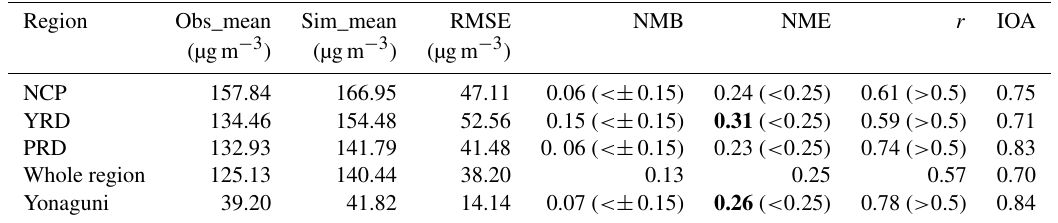
Table 2. Model performance metrics for 1h O 3 in mainland China and at Yonaguni island. The benchmarks are taken from Emery et al.